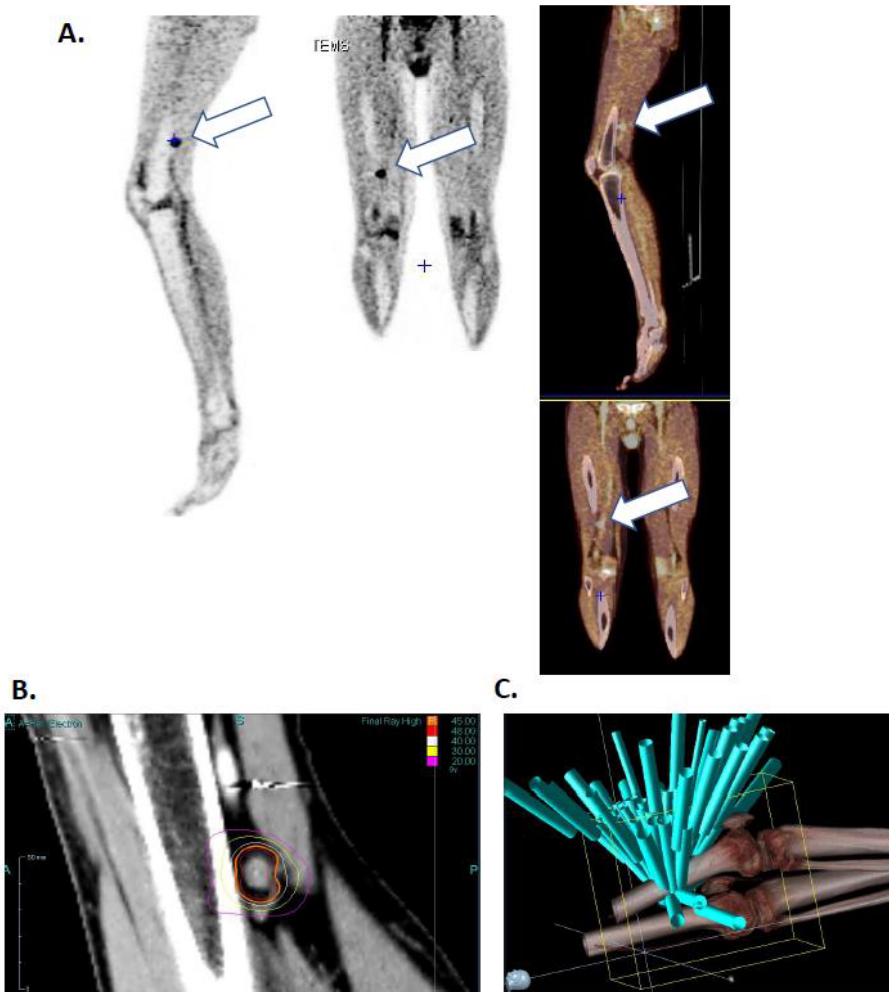
Figure 1. Patient’s right leg positron emission tomography (TEP) image (17 / 02 / 2016) ( A ), image of isodose curve around the lesion ( B ) and visualization of the 65 irradiation ray ( C ) White arrow point patients irradiated tumor.